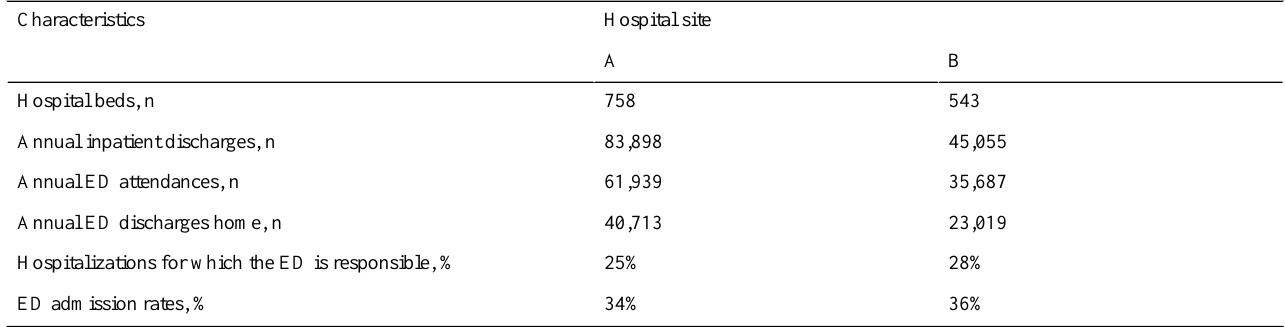
Table 1. Characteristics of 2 hospital emergency department (ED)